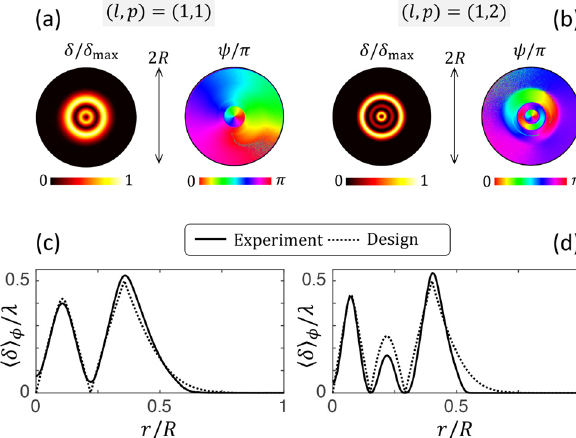
Figure 6: Experimental structural characterization of the modal vortex shapers with ( l , p ) = (1 , 1) and ( l , p ) = (1 , 2). (a) and (b) Spatial distribution of the retardance 𝛿 and azimuth 𝜓 spatial distributions retrieved by optical polarimetric means. (c) and (d) Radial profiles of the reduced retardance extracted from the latter maps. The notations are identical to that of Figure